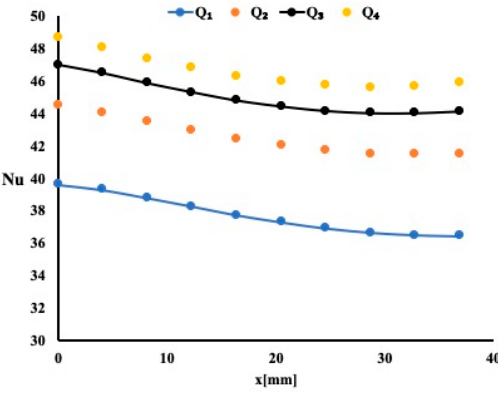
Figure 4. Local Nusselt number variation for different flow rates.